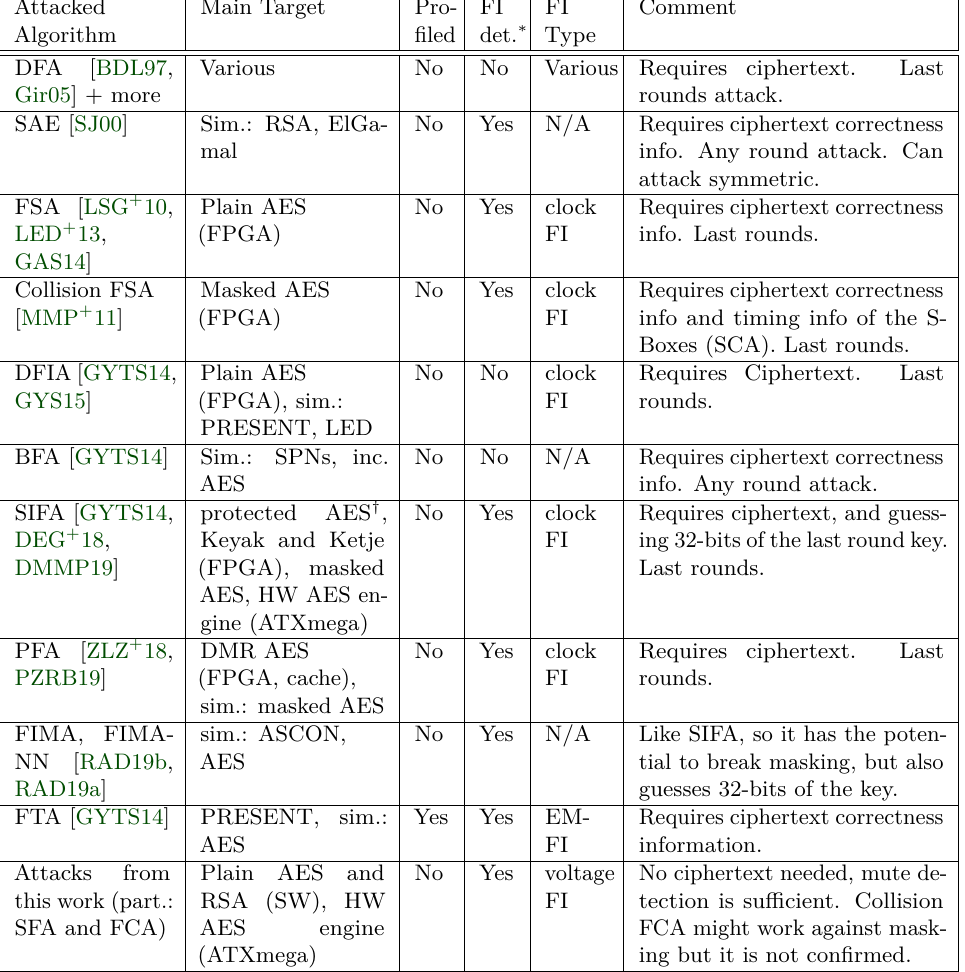
Table 1: Comparison of various Fault Injection